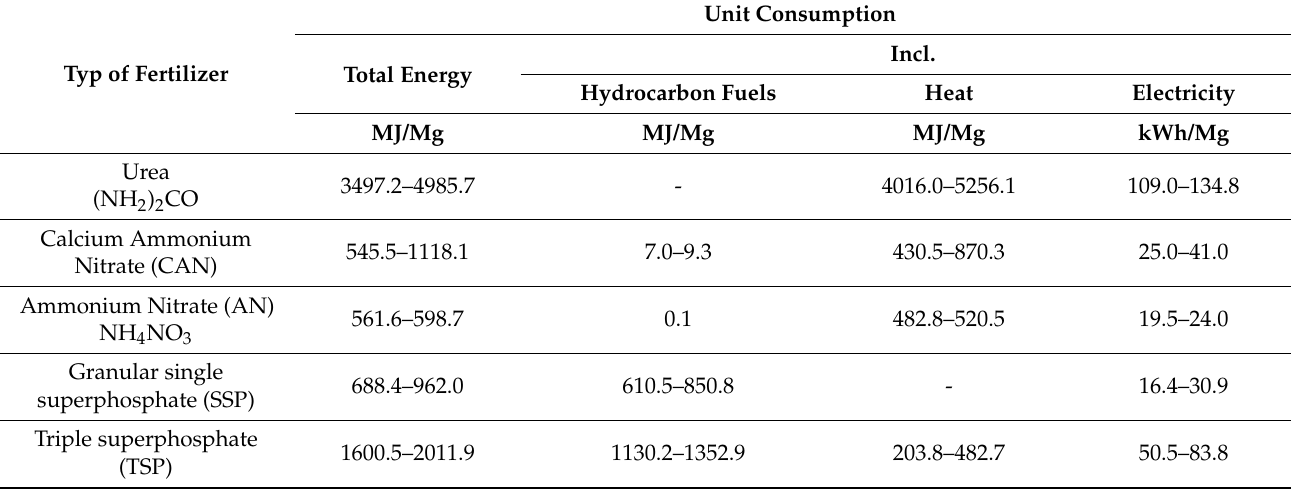
Table 2. Energy consumption of selected fertilizers [53].